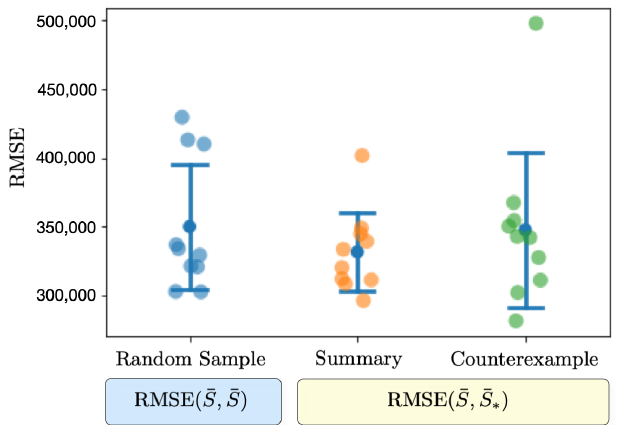
) standard deviation and mean for two ∗